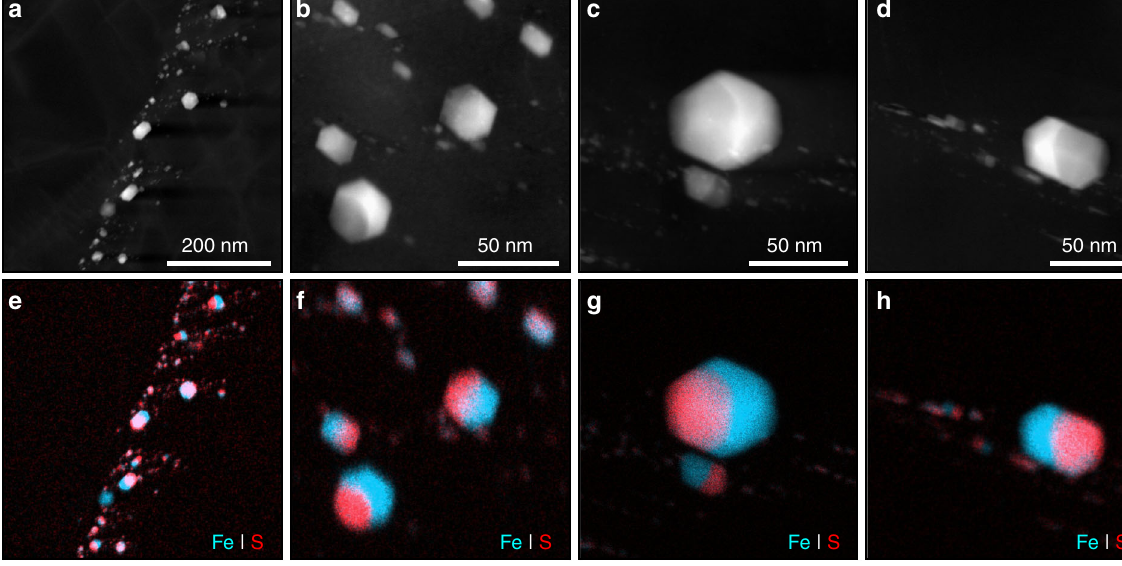
Fig. 3 Electron micrograph and compositional maps of diamond inclusions in ureilite. HAADF-STEM images ( a , b , c , and d ) and associated Fe and S elemental maps ( e , f , g , and h ) of inclusions in diamond. All chemical (EDX) maps show Fe (light blue) and S (red) distribution. Kamacite and troilite phases appear as light blue and reddish-pink respectively